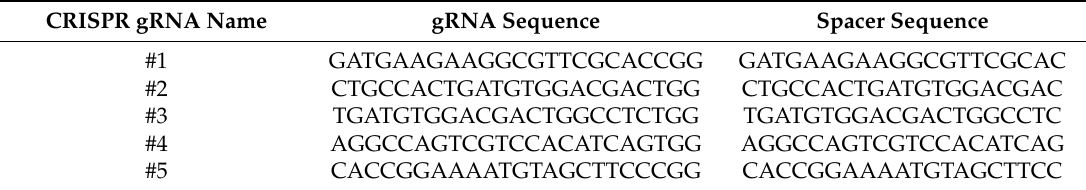
Table 1. CRISPR guide RNA sequences. Five different guide RNAs were designed complimentary to the Numb gene sequence and with minimal off-target